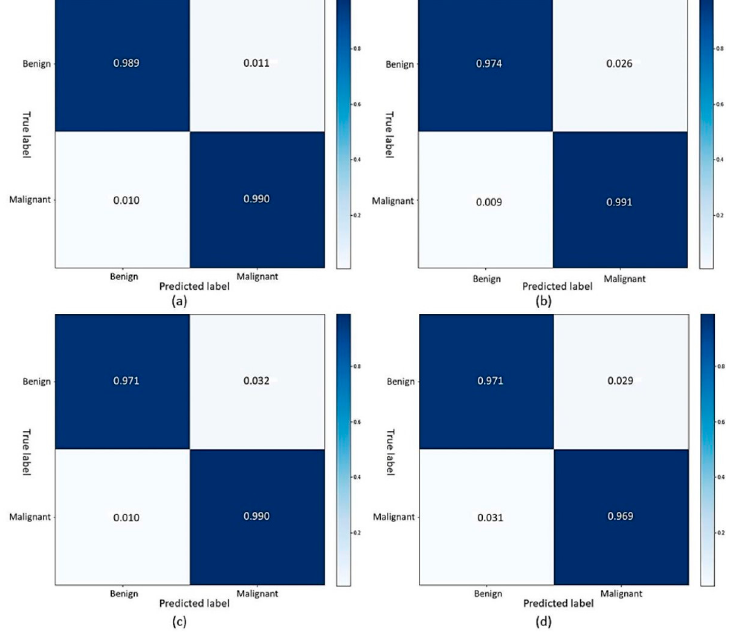
Figure 9. Confusion matrices of FabNet that for BreakHis, ( a ) confusion matrix of 40× magnification, ( b ) confusion matrix of 100× magnification, ( c ) confusion matrix of 200× magnification, ( d ) confusion matrix of 400× magnification. The confusion matrix results for multi-classification in the case of NCT-CRC colon cancer are shown in Figure 10.